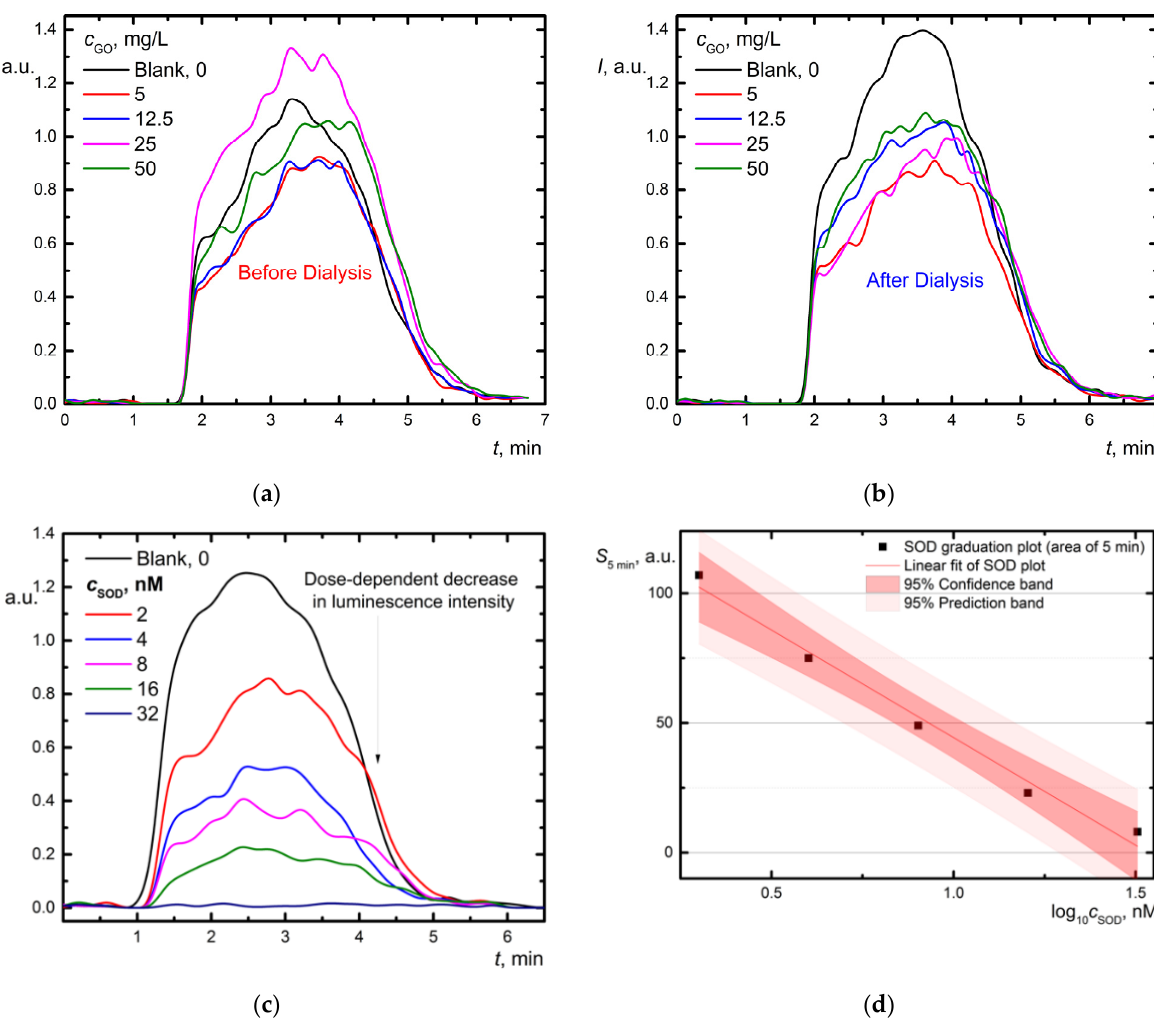
Figure 6. Oxidation of xanthine (20 µM) with xanthine oxidase (4.4 mU/mL) in the presence of lucigenin (20 µM) and GO aqueous dispersions in the range of 5–50 mg/L: ( a ) before dialysis; ( b ) after dialysis; ( c ) source chemiluminograms for SOD; and ( d ) dependence of the light sum ( S 5min is area under curve for 5 min) vs. log 10 c (SOD); S 5min = ( − 83 ± 6) × log 10 c (SOD, nM) + (127 ± 10), r = 0.992. Concentrations are shown in the legends. The total volume, 1.00 mL; temperature, 37 °C.